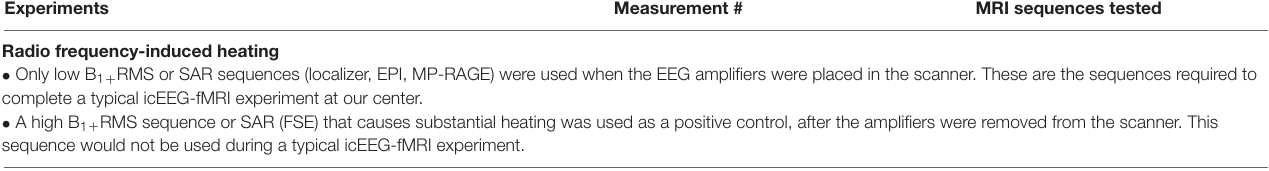
Experiments Measurement # MRI sequences